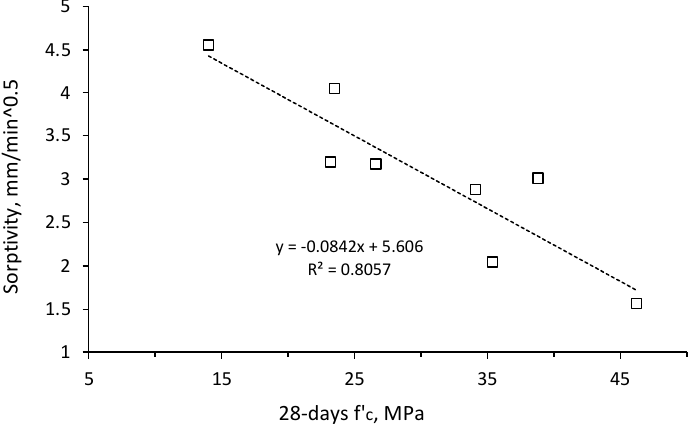
Figure 8. Relationship between 28 d 𝑓 𝑐′ and water sorptivity.